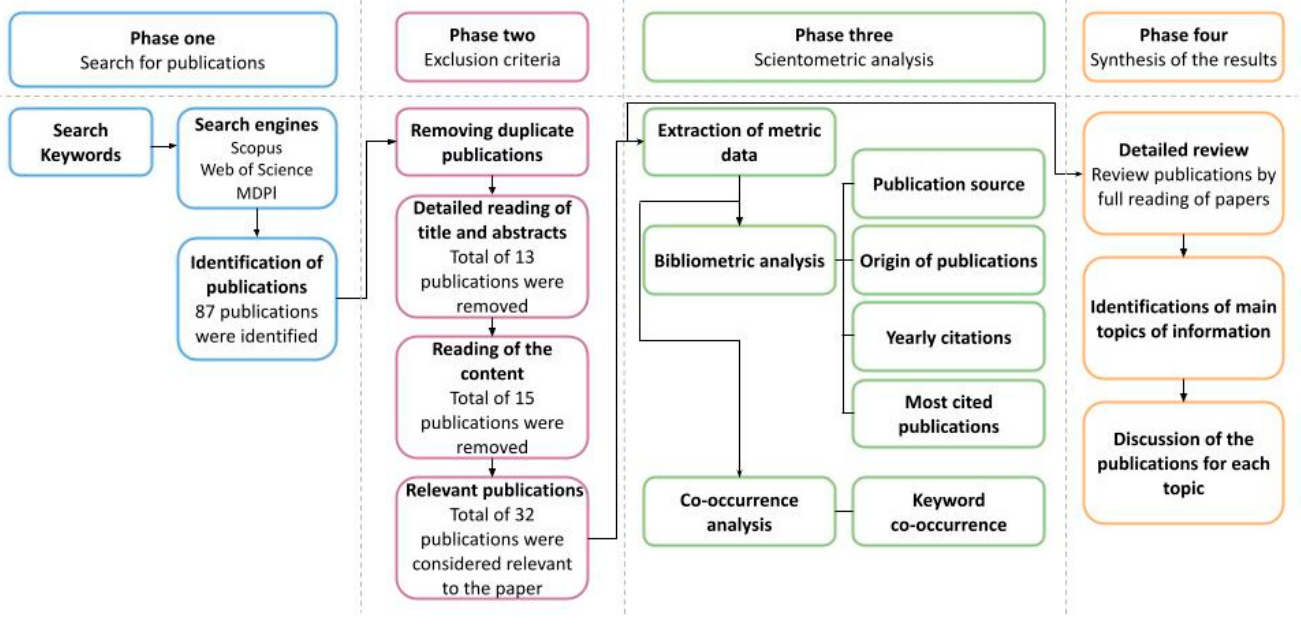
Figure 1. Research methodology.